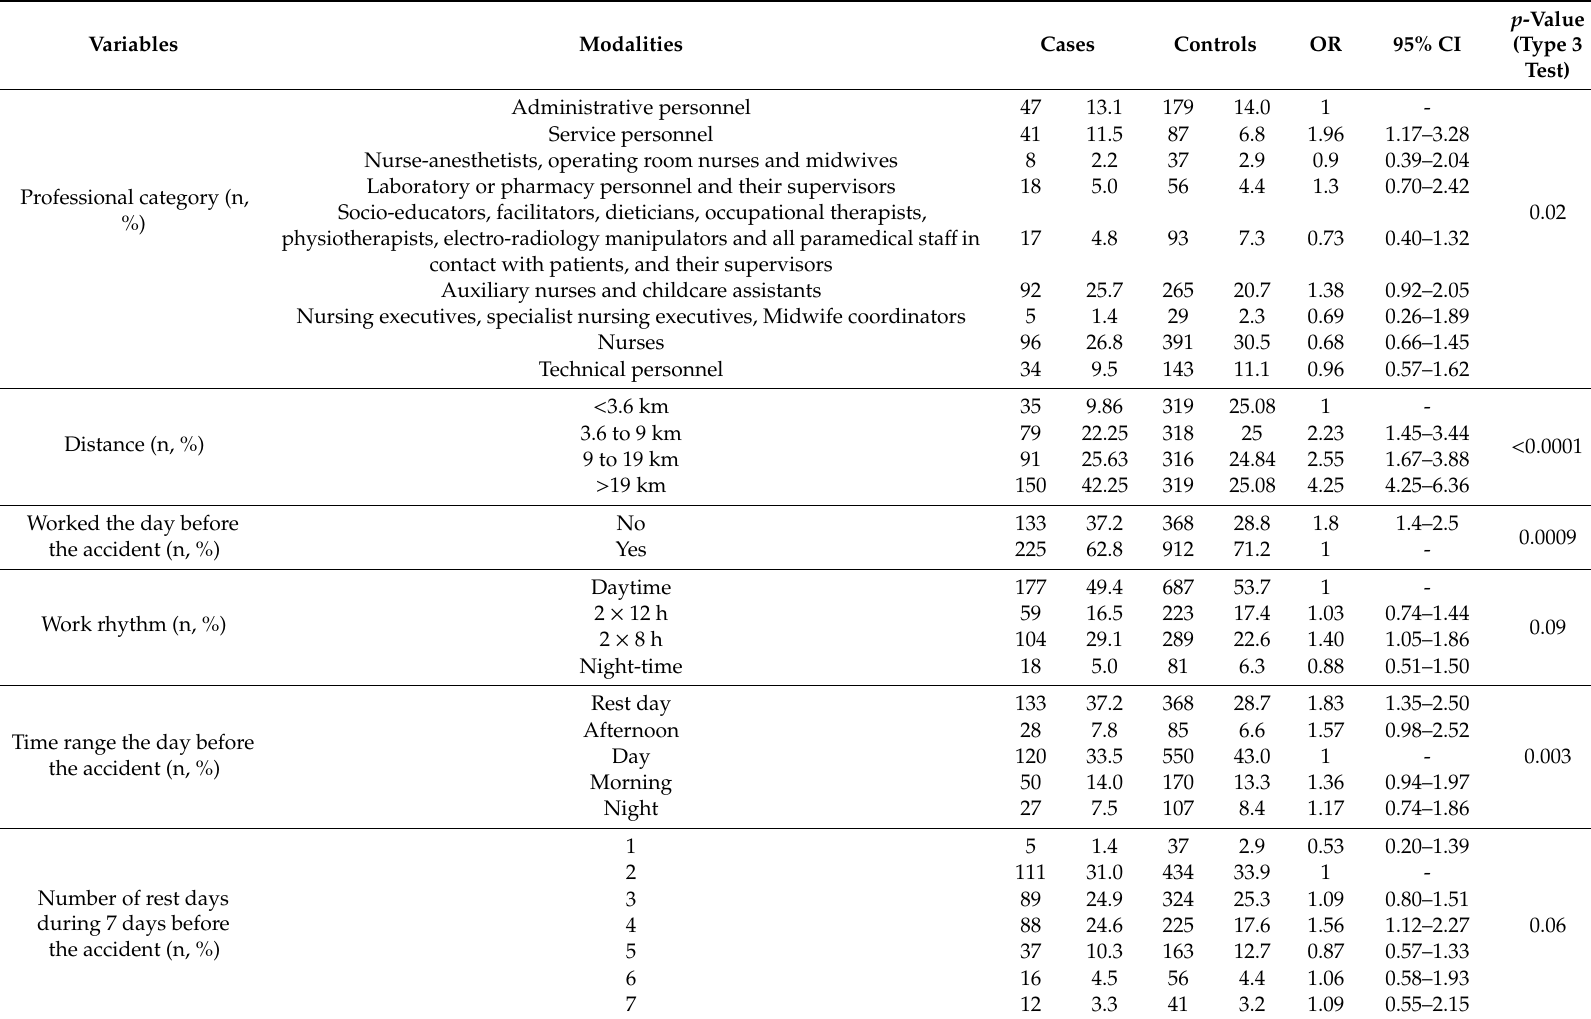
Table 2. Univariate analyses of commuting accidents from 2012 to 2016 in cases and controls drawn from non-physician sta ff working in a large teaching hospital center. Variables Modalities Cases Controls OR 95% CI